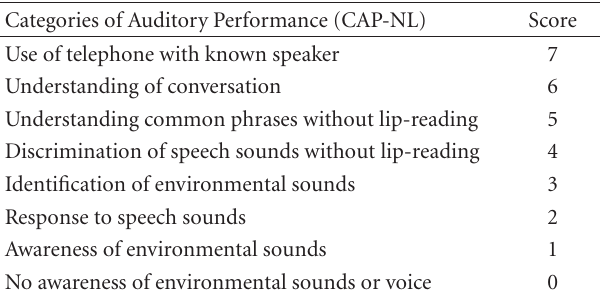
Table 2: The dutch categories of auditory performance (CAP-NL). Categories of Auditory Performance